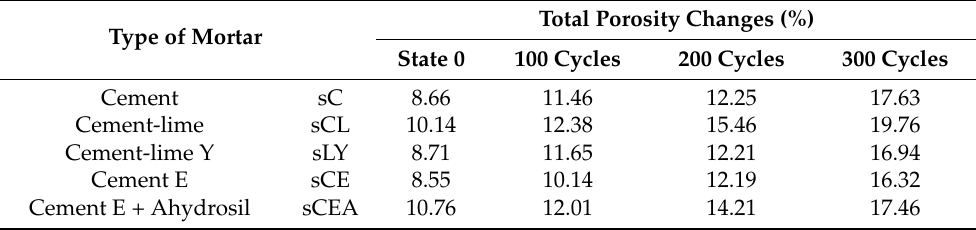
Table 2. Porosity changes of mortar samples in the CAT chamber exposed to simulate environment (own table based on